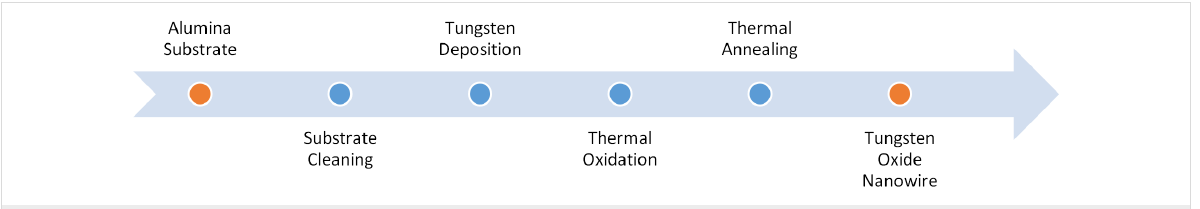
Figure 15: Flow chart describing the synthesis process of tungsten oxide nanowires.